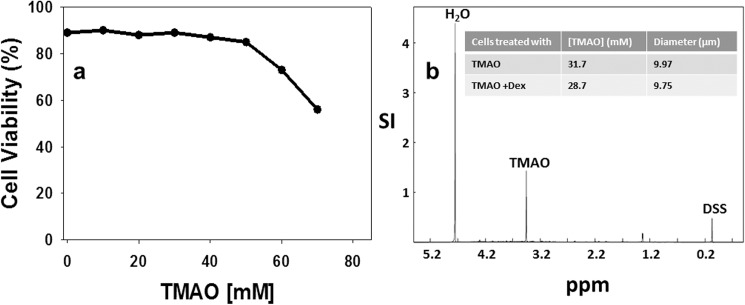
Estimating Concentrations of TMAO in the NMR Sample.(A) Establishing tolerable level of TMAO. Culture medium was brought to Final TMAO concentrations shown and cell viability assayed (trypan blue exclusion). (B) 1H-NMR analysis to determine intracellular TMAO levels in cells bathed in medium containing 50mM TMAO. Using a tool in the VNMRJ software, integrals of TMAO peaks were taken in samples and compared to injected DSS reference peak. Molar concentration of TMAO in sample calculated by comparing these two ratios (one of known concentration).